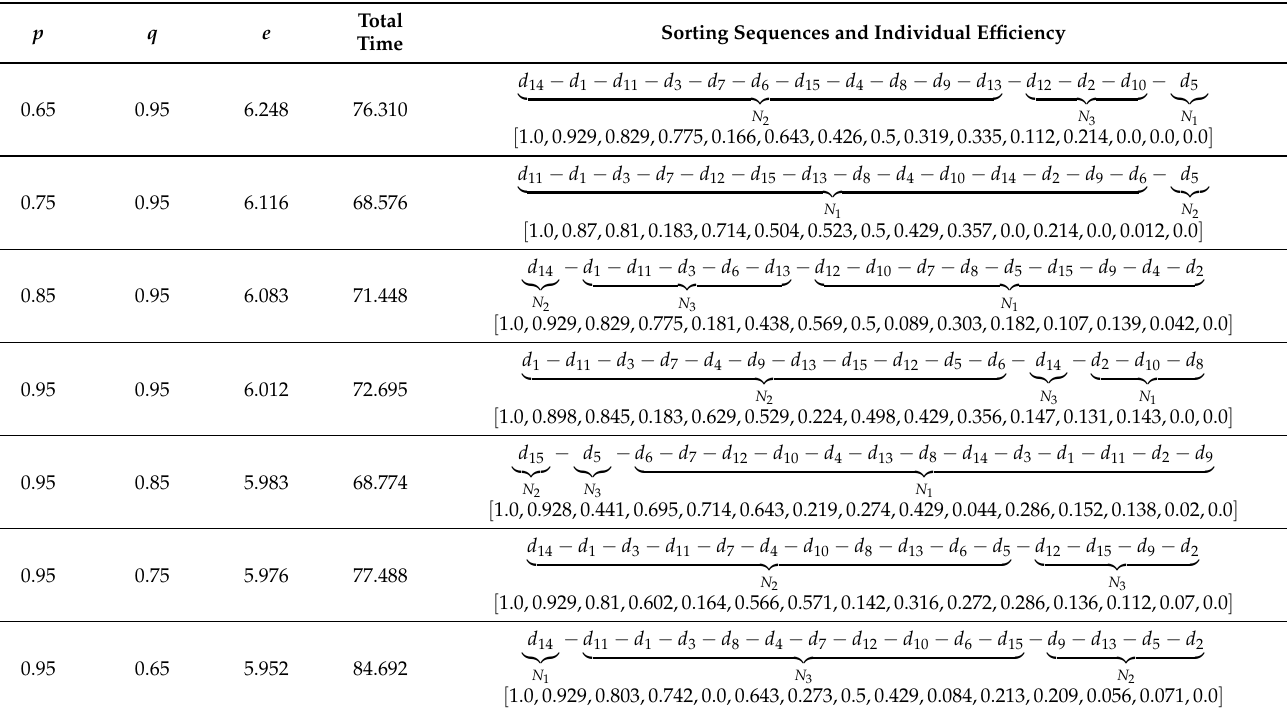
Table A1. Solutions of sorted negotiation model with different p , q ( o (cid:48) = 107, B 0 = 2400, T = 85). Sorting Sequences and Individual Efficiency